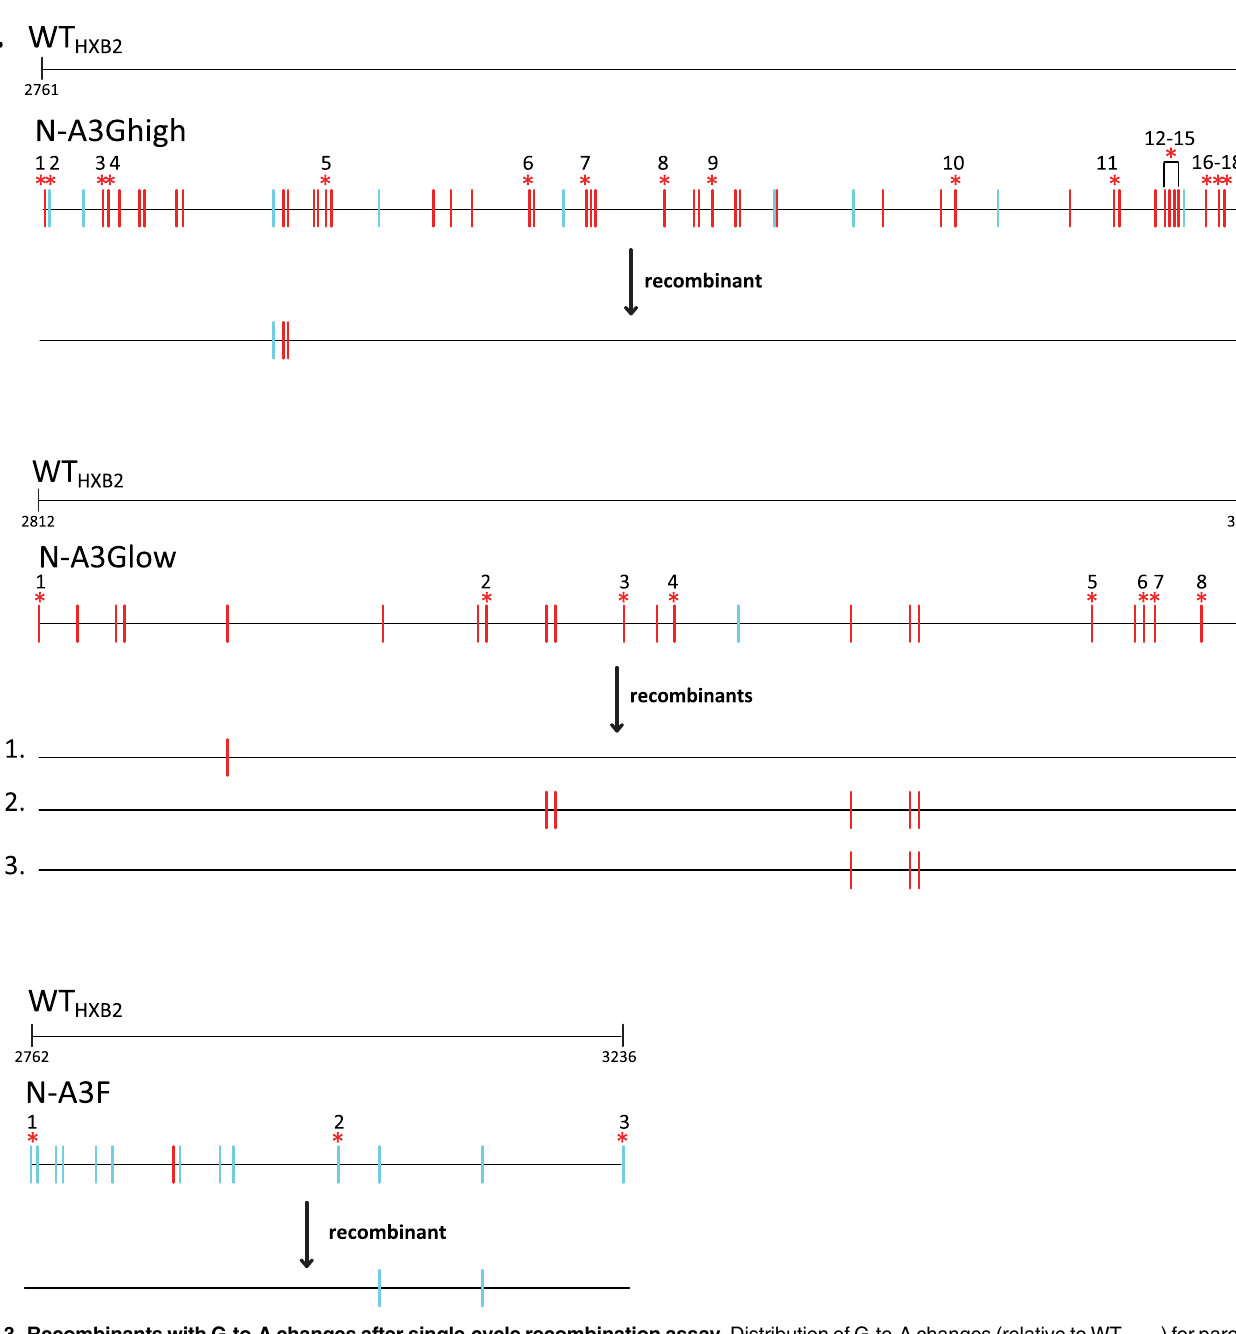
PLOS Pathogens | DOI:10.1371/journal.ppat.1005646 May 17,